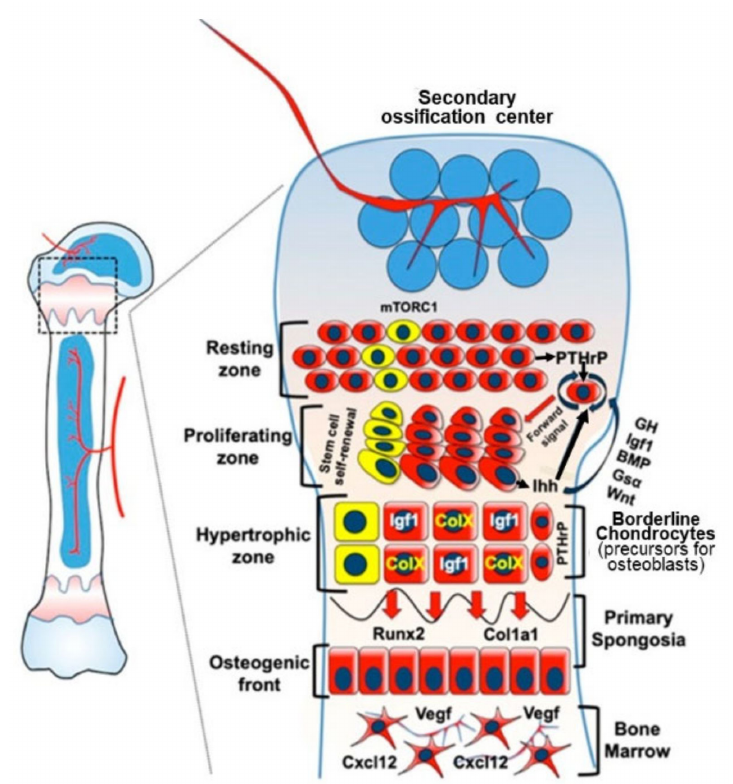
Figure 2. Endochondral ossification: molecular characteristics of growth plate chondrocytes and their differentiation trajectories. Stem cells in the resting zone express the transcription factor SOX9 which drives their commitment and differentiation into chondrocytes. The initial development of the secondary ossification centre stimulates the expression of parathyroid hormone-related protein (PTHrP) by skeletal stem cells in the resting zone niche. This population contributes to the formation of proliferating and hypertrophic chondrocytes in addition to marking collagen Type I Alpha 1 Chain, (Col1a1+), osteoblasts in the primary spongiosa and stromal cell-derived factor 1, (Cxcl12), expressing bone marrow stromal cells in the marrow cavity over time. PTHrP acts to delay differ- entiation and keep the chondrocytes in a proliferative state, becoming organised into clones that arrange themselves into columns, contributing to bone elongation via interaction with adjacent cells. However, when these cells become sufficiently distant from the source of PTHrP due to interstitial growth, they differentiate into pre-hypertrophic and early hypertrophic chondrocytes, which are postmitotic cells that express Indian hedgehog (Ihh). This factor diffuses up the column to stimulate further PTHrP secretion to maintain the proliferative nature of the chondrocytes. After terminal differentiation, chondrocytes enlarge and this is the major contributing factor regulating the growth rate in endochondral bones. mTORC1 activity maintains the stem cells in their niche and remains important throughout proliferation and hypertrophy. Growth hormone acts within the resting zone to increase expression of IGF-1 and its receptor which is important for the PTHrP-Ihh feed-back loop and for the process of hypertrophy. T3 (not shown) is widely involved with indirect effects involving enhancing IGF-1 action and directly inhibiting proliferation and stimulating pre-hypertrophic and hypertrophic chondrocyte differentiation [120]. Bone morphogenetic proteins (BMPs) and their receptors are expressed in proliferating and hypertrophic chondrocytes and BMP signalling regulates chondrocyte proliferation and differentiation in part within the PTHrP-Ihh feed-back loop and by maintaining SOX9 activity. Gs α is a GTPase which activates adenyl cyclase to increase cyclic AMP and mediates the action of PTHrP and inhibits Ihh. Wnt(Wingless-related integration site signal- ing glycoproteins)/ β -catenin signalling promotes differentiation of proliferating chondrocytes into hypertrophic chondrocytes both by antagonising PTHrP and independently of PTHrP signalling. Copied and adapted from Hallett et al. (2019) [48] under the Creative Commons Attribution 4.0 International